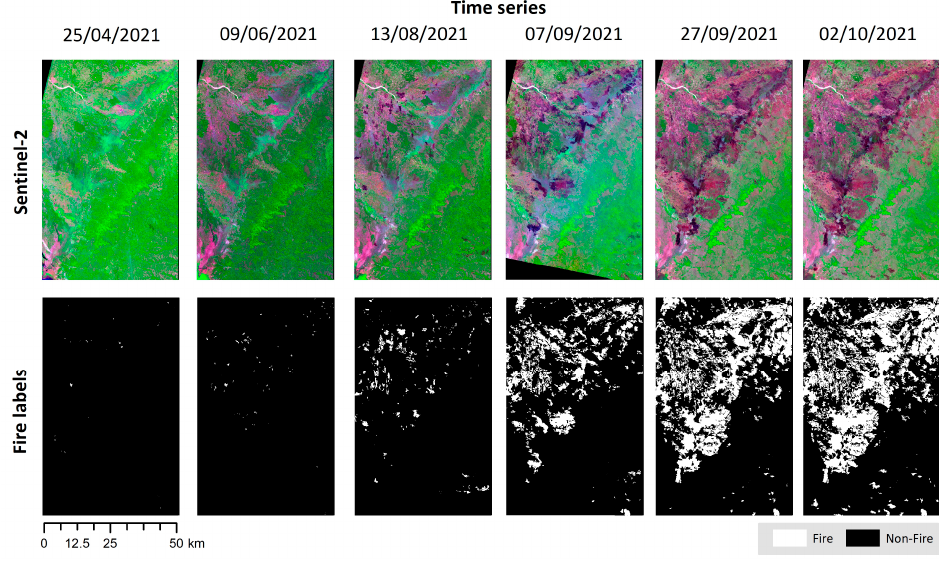
Figure 2. Examples of the spatiotemporal patterns of fires derived from Sentinel-2 for a part of the study area in 2021. Fire labels are not affected (black) and affected (light grey).